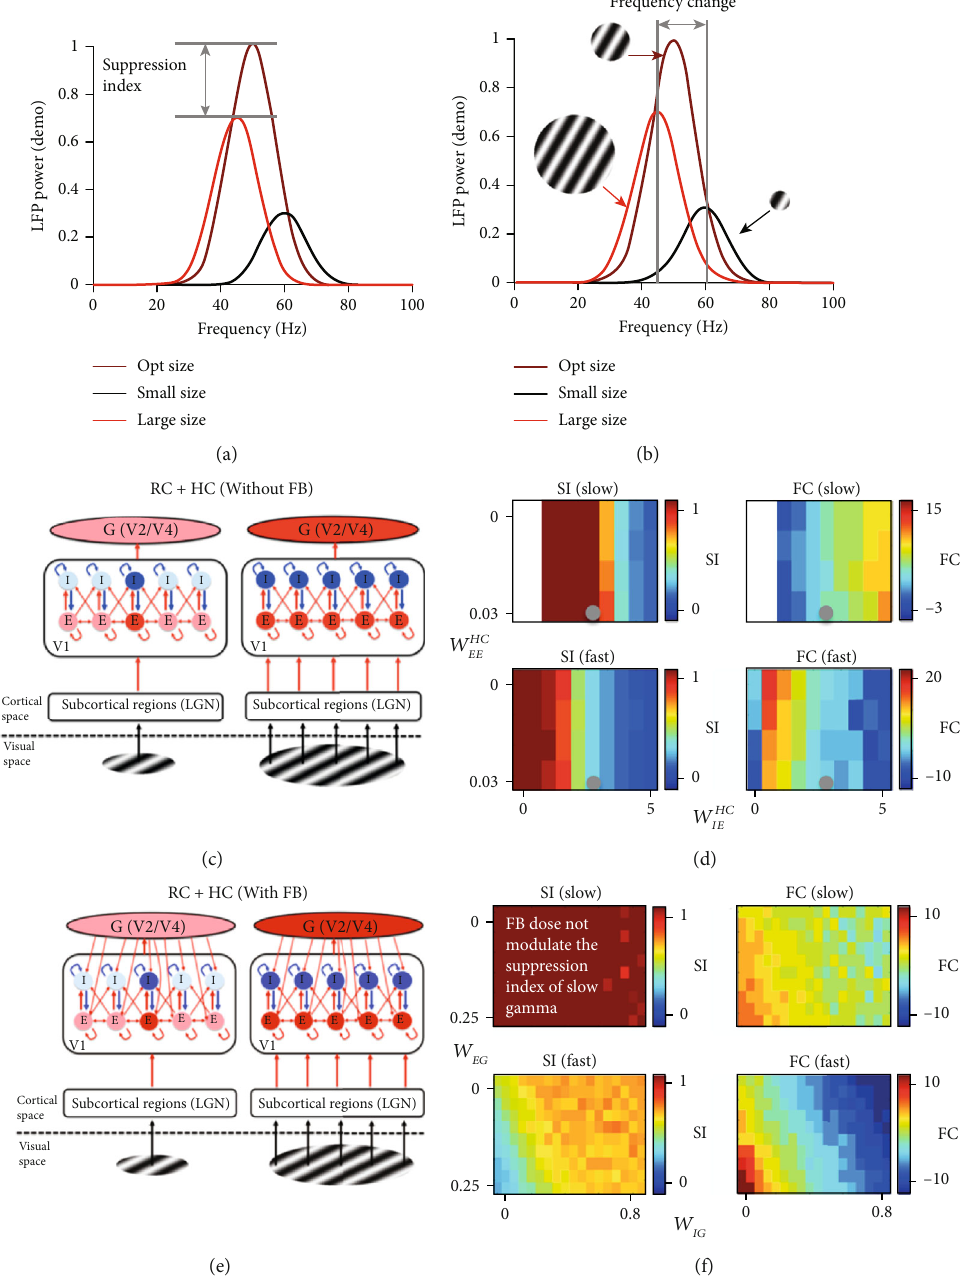
Figure 7: Size dependence of gamma in the HC network with and without FB. The calculation of two indexes (suppression index (SI) and frequency change (FC)) that capture the size-dependent property of gamma was shown in (a) (suppression index) and (b) (frequency change). The curves in di ff erent colors mean the power spectrums under di ff erent stimulus sizes. (c) shows an HC network without FB driven by a small stimulus (left panel) and by a large stimulus (right panel). Components weakly or not activated by the stimulus are shown as light red or light blue color and components in red or blue are those strongly activated by the stimulus. The left column of (d) shows how the suppression index changes with strengths of W HC EE and W HC IE for slow (upper panel) and fast gamma (lower panel) oscillation, and the right column of (d) shows how gamma frequency changes with strengths of W HC EE and W HC IE for slow (upper) and fast gamma (lower) oscillation. (e) shows a network with both HC and FB driven by a small stimulus (left panel) and by a large stimulus (right panel). Notice that the network in (e) and (c) are the same, except that network in (e) has FB, but the network in (c) does not. The panels in (f) are also similar to those in (d), but the x -axis and y -axis is for strengths of W EG and W IG